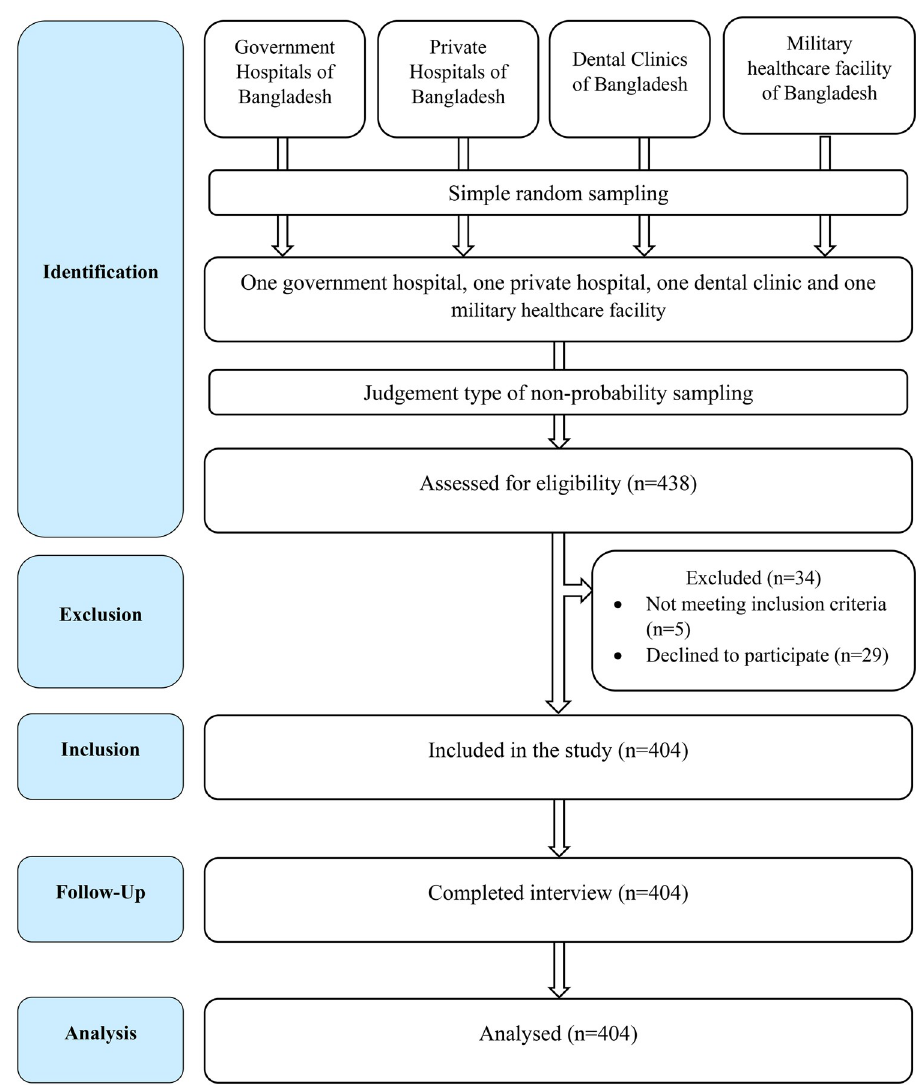
Fig 1. STrengthening the Reporting of OBservational studies in Epidemiology (STROBE) flow chart of study participants.